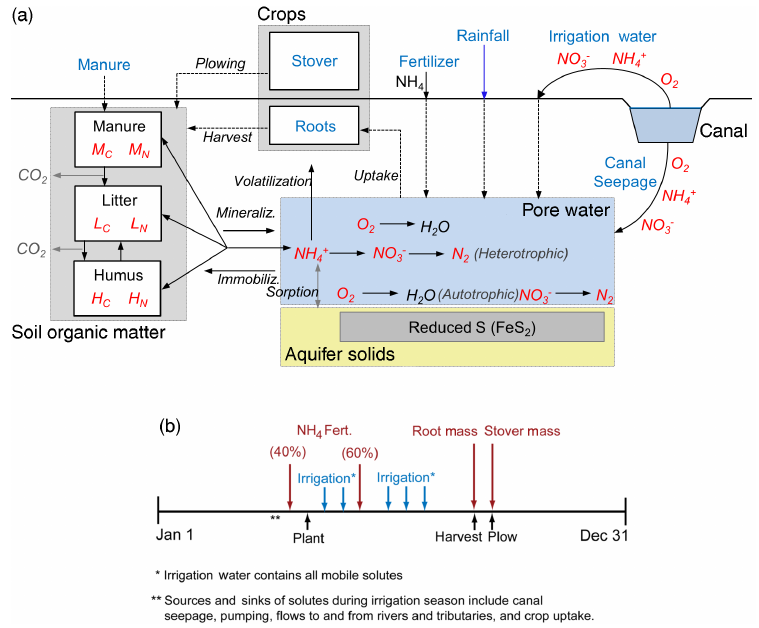
Figure 3. Depiction of the main processes simulated by the N reaction module of the UZF-RT3D model, with (a) conceptual model of the fate and transport of O 2 and N species in an irrigated soil–aquifer system wherein fertilizer, irrigation, and canal seepage bring solute mass into the subsurface environment, and (b) the annual cultivation schedule used in the N reaction module, including timing of planting, fertilizer loading, irrigation application, harvest, and plowing. NH 4 fertilizer has a split loading, with 40% of the loading occurring 2 weeks before planting, and the remainder applied 6 weeks after